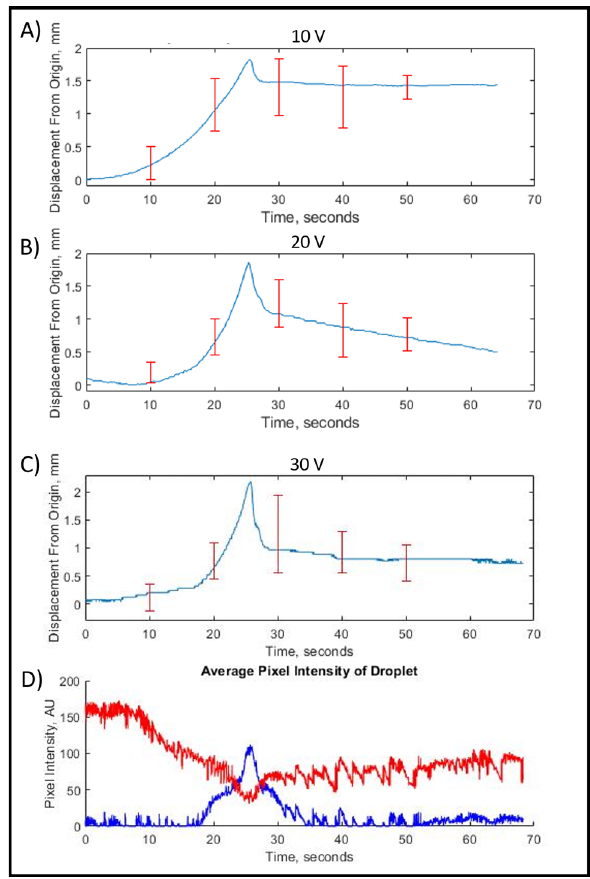
Figure 3. Relationship between the displacement of droplets and the redox states within droplets. ( A – C ) Average droplet displacement as a function of time from droplets subject to DC fields with 10 V, 20 V and 30 V, respectively. All curves were averaged over 10–15 sample data sets by shifting their peak displacements to the same reference time, and the error bars represent the standard deviations in the data sets. ( D ) Average pixel intensity values for the red and blue channels of the droplet RGB images. The chemical wave propagates across the droplet driving it to undergo translational motion under a 30 V DC